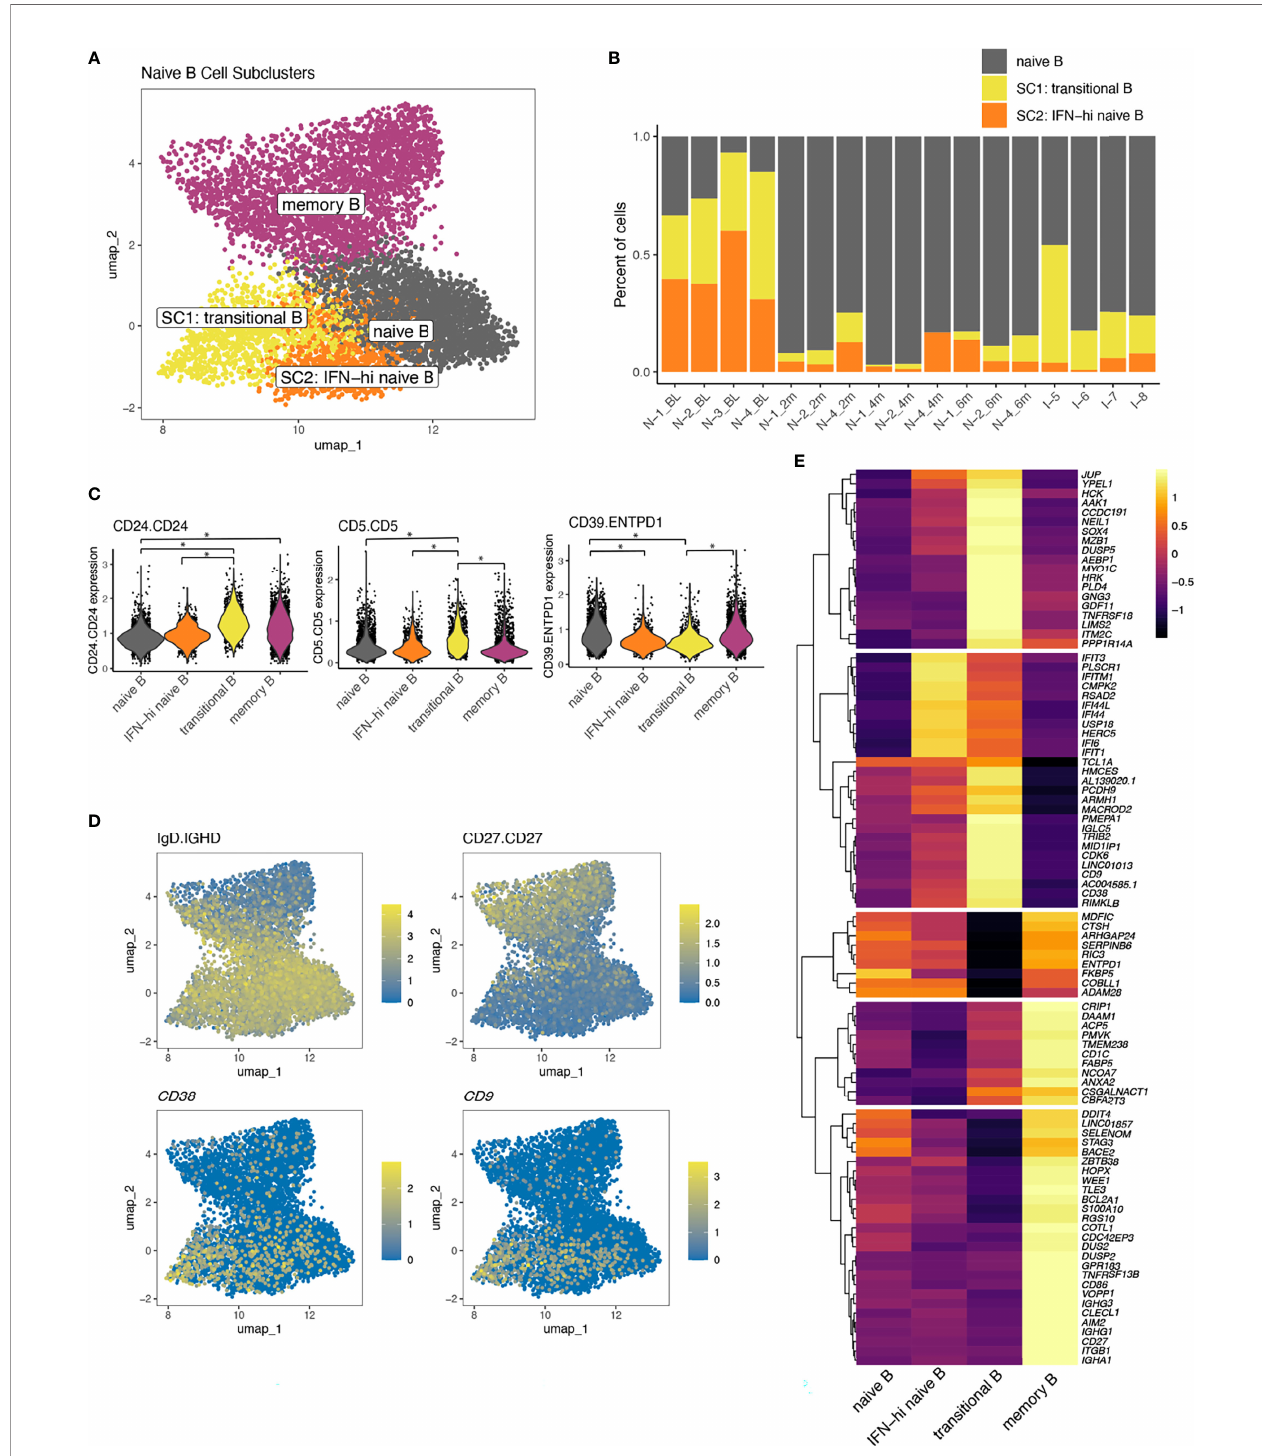
FIGURE 5 | (A) A UMAP of B cell populations after a second round of naïve B cell clustering colored by naïve B cell subcluster. (B) The proportion of cells making up the naïve B cell subclusters per sample ordered by time and disease group. (C) Violin plots displaying expression values of differentially expressed proteins between naïve B cell subsets using a log-fold change >0.5 and adjusted p-value <0.05 indicated by *. (D) UMAPs of B cell populations displaying log-normalized expression of phenotypic markers IgD (protein), CD27 (protein), CD38 (RNA) and CD9 (RNA). (E) A heatmap displaying differentially expressed transcripts comparing transitional B cells to all other B cells and IFN-high naïve B cells to all other B cells. Genes displayed are those with a log-fold change>1.3 and adjusted p-value <0.05. All genes differentially expressed meeting log-fold change >1 are displayed in Supplementary Table 4